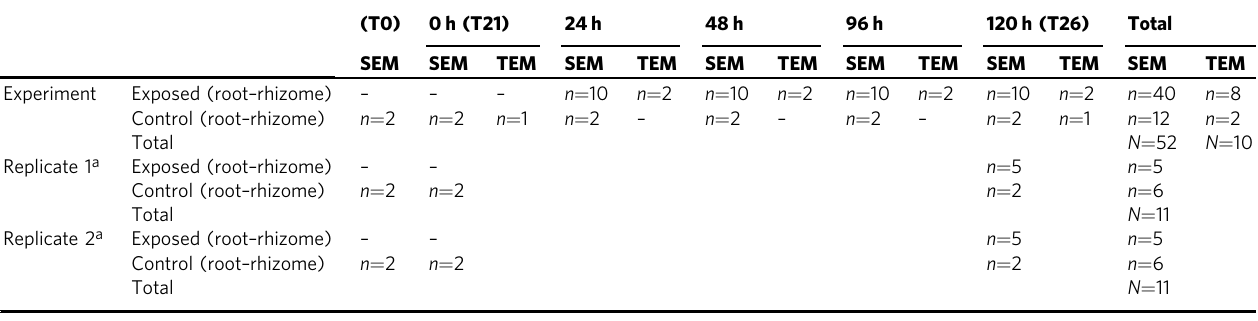
Table 2) and fi xed for ultrastructural analysis (SEM and TEM). For SEM, the PRE data set consisted of two samples taken at the moment of plant arrival in